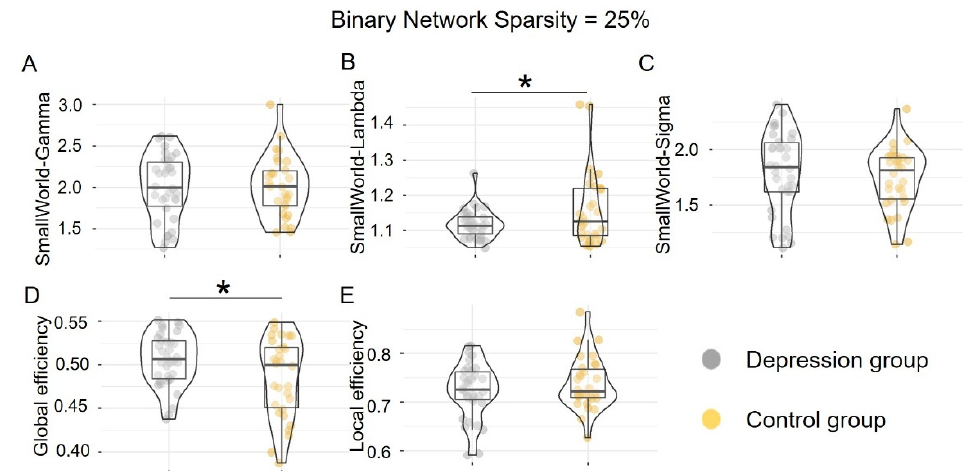
Figure 4. Group differences in five global properties in binary brain networks (sparsity threshold = 25%). The upper three panels ( A – C ) correspond to the small-world metrics: Gamma, Lambda, and Sigma, respectively. The lower two panels ( D , E ) refer to global and local efficiency. * p < 0.05.